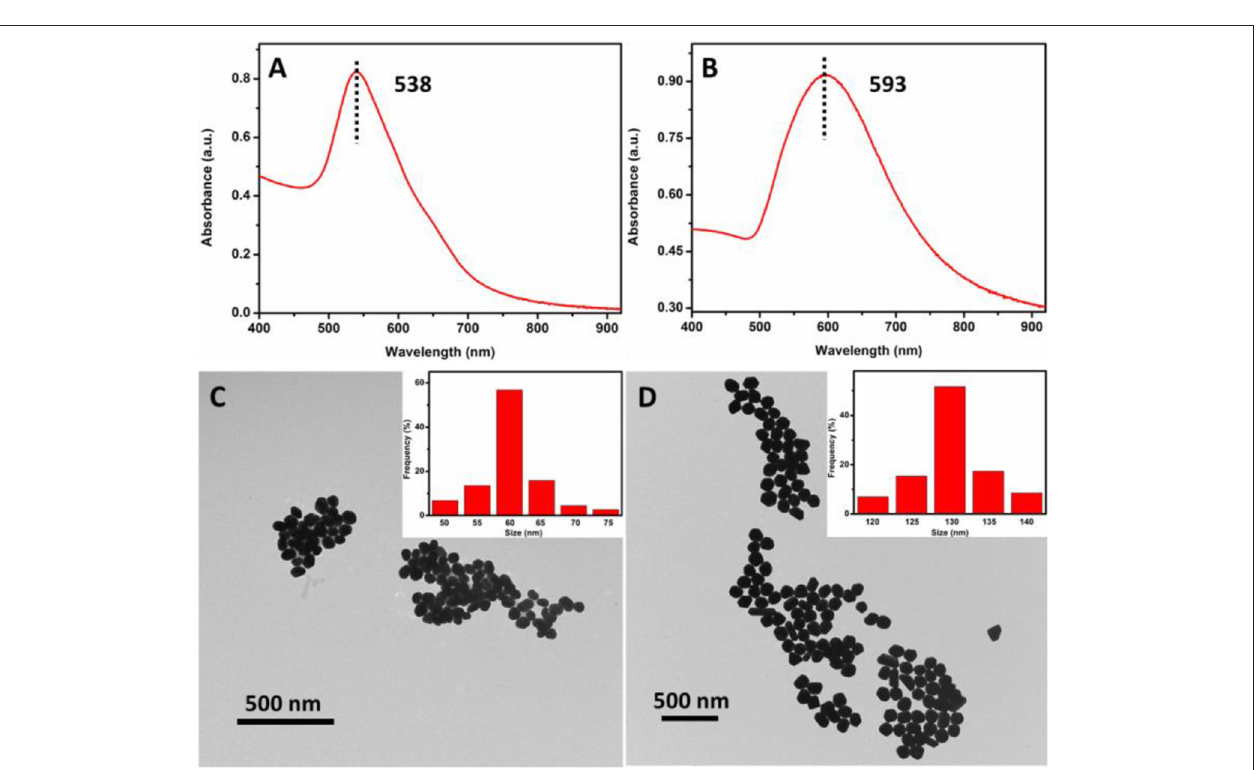
FIGURE 3 | UV-vis spectra (A,C) and TEM images (B,D) of the as-prepared 60 and 130nm AuNPs, respectively.